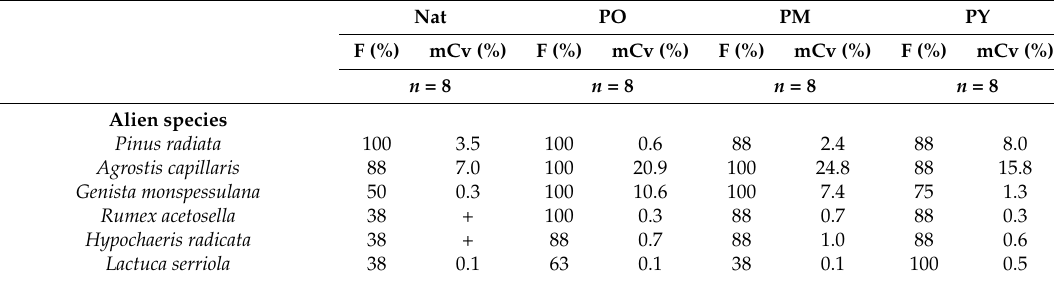
Table A3. Species recorded at roadside transects of the natural forest (Nat), old to mature pine plantations (PO), medium-aged pine plantations (PM) and young pine plantations (PY). Given are occurrence frequency values (F) representing the percentage occurrence in transects and the mean cover values (mCv) in % (cover values of + are < 0.05%). Alien and native origin according to Zuloaga et al. [48]. * marks endemic species. Species are ordered based on their decreasing frequency from the natural forest to young